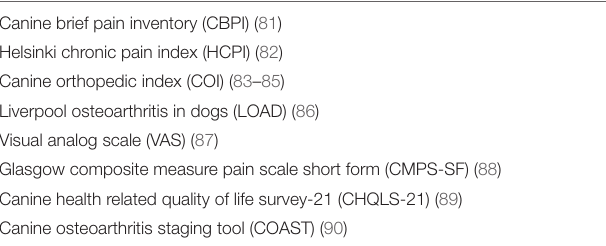
TABLE 6 | Validated client surveys for canine pain and quality of life